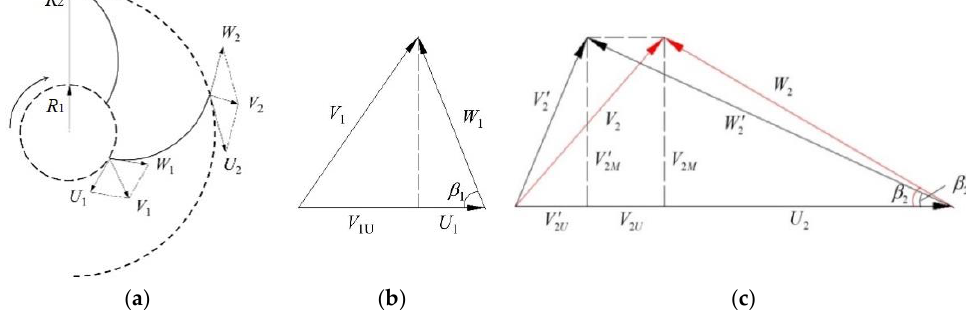
Figure 10. Velocity triangles: ( a ) blade to blade impeller flow channel; ( b ) inlet velocity triangle; ( c ) outlet velocity triangle.